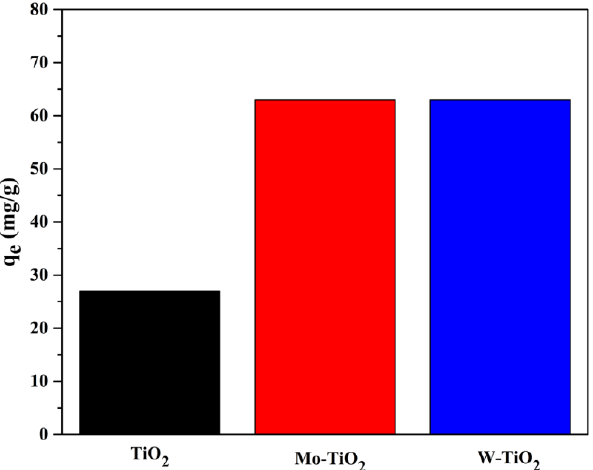
Figure 17. The adsorption capacities of TiO 2 , Mo ‐ TiO 2 , and W ‐ TiO 2 . Further addition of Co to Mo-TiO 2 had a negative impact on the adsorption perfor-